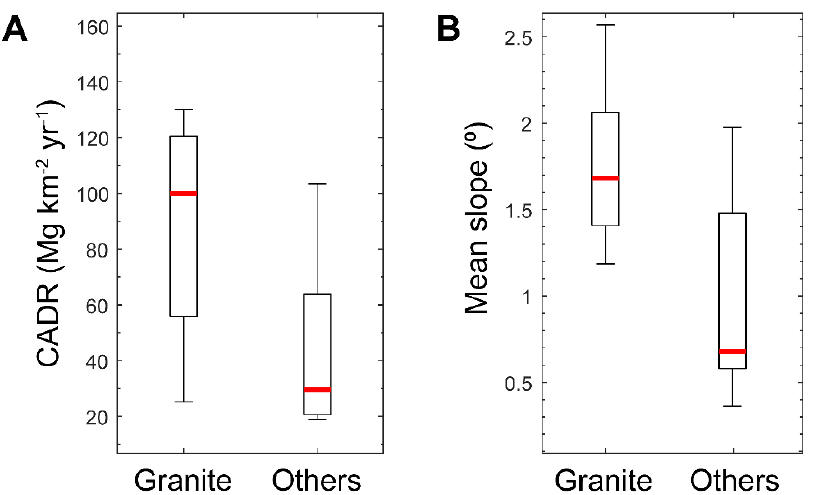
Figure 7. Box and whisker plots comparing granite and other rock types for CADR and mean slope.